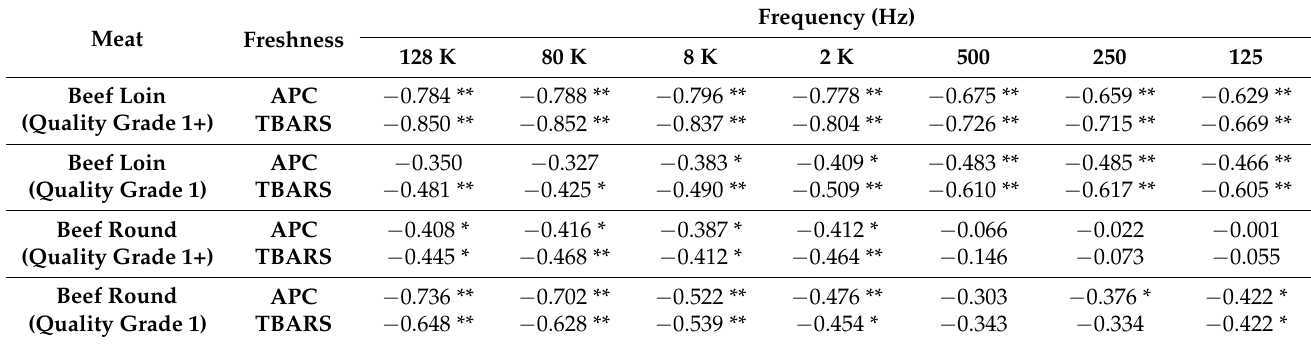
Table 1. Correlation coefficients between each impedance at different frequencies and freshness of beef.